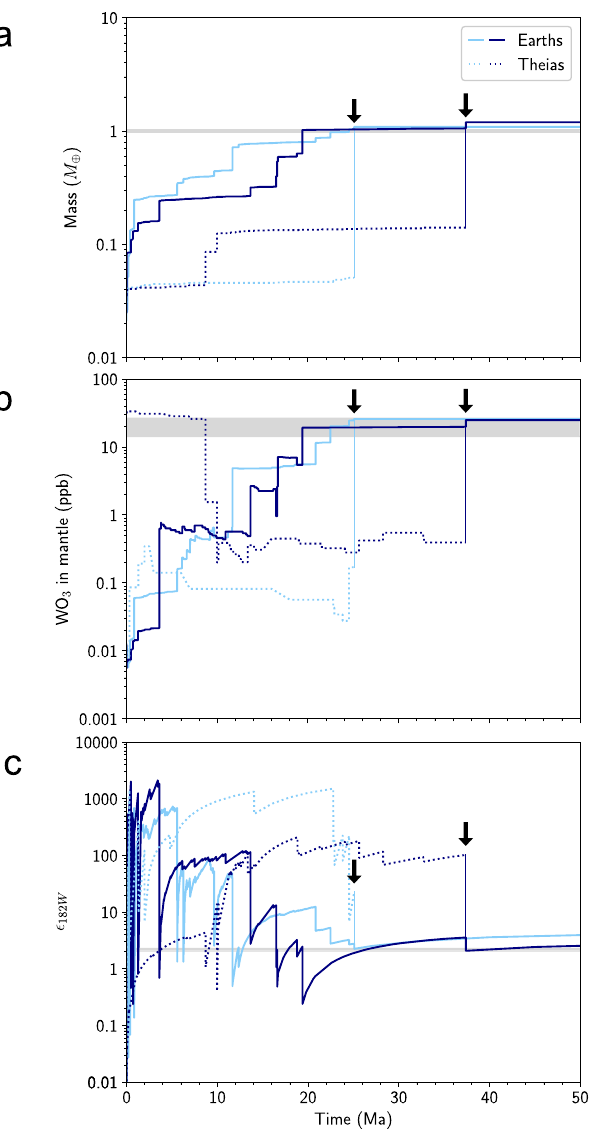
Fig. 1 Evolution of mantle W in Earth and Theia analogs. As Earth and Theia accrete, their masses increase in a stepwise fashion ( a ). Their mantle tungsten abundances (WO 3 in mantle) also generally increase, depending on the evolution of their oxidation states ( b ). Their mantle ε 182W increase between impacts as 182 Hf decays into 182 W, faster at earlier times and slower after more half-lives of 182 Hf (~9 Ma) have passed. With each impact, metal – silicate equilibration draws down the 182 W in the mantle, decreasing ε 182W ( c ). ε 182W can reach very high values at early times, because W is more strongly siderophile at low pressure – temperature – oxygen fugacity conditions. Two example Earth – Theia pairs are shown (light and dark blue) from Eccentric Jupiter and Saturn (EJS) simulations. Solid lines: Earth analogs. Dotted lines: Theia analogs. Gray shaded regions indicate Earth values 5,43 . Thin vertical solid lines with black arrows represent the Moon-forming equilibration k , assuming the Moon formed entirely from Theia materials. For k = 0.4, CJS/EJS Earth analogs match the observed ε 21 , but many Moon analogs have anomalies that 182W on average are too high. For a lunar D W = 30, 75% of CJS/EJS Moon analogs have ε 182W that are higher than the observed value (median 3.9),